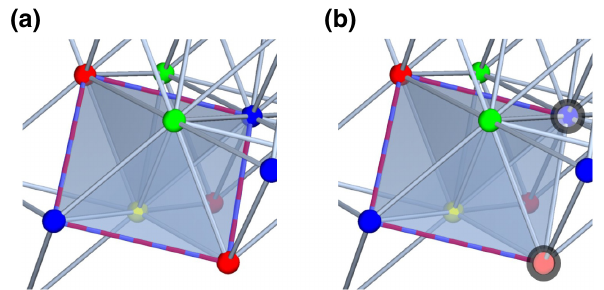
FIG. 27. (a) The flux γ (highlighted RB edges) due to a sin- gle GY -edge generator (shaded four tetrahedra) contains only RB edges. This set of edges γ satisfies the Gauss law. (b) A noisy measurement of the flux may not be valid, meaning it does not satisfy the Gauss law. Here (cid:6) γ has two violation points (highlighted R and B vertices) at which the Gauss law is not